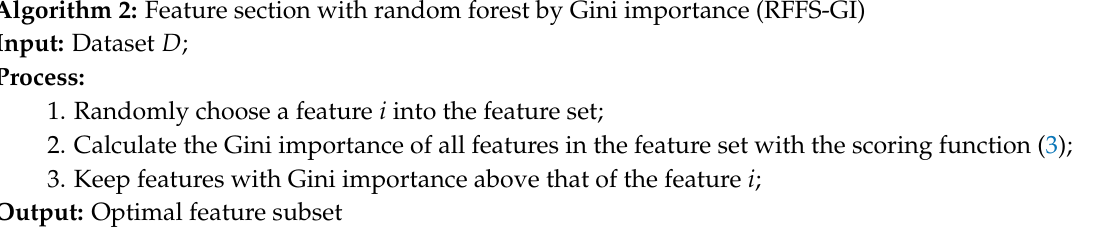
Algorithm 2: Feature section with random forest by Gini importance (RFFS-GI)